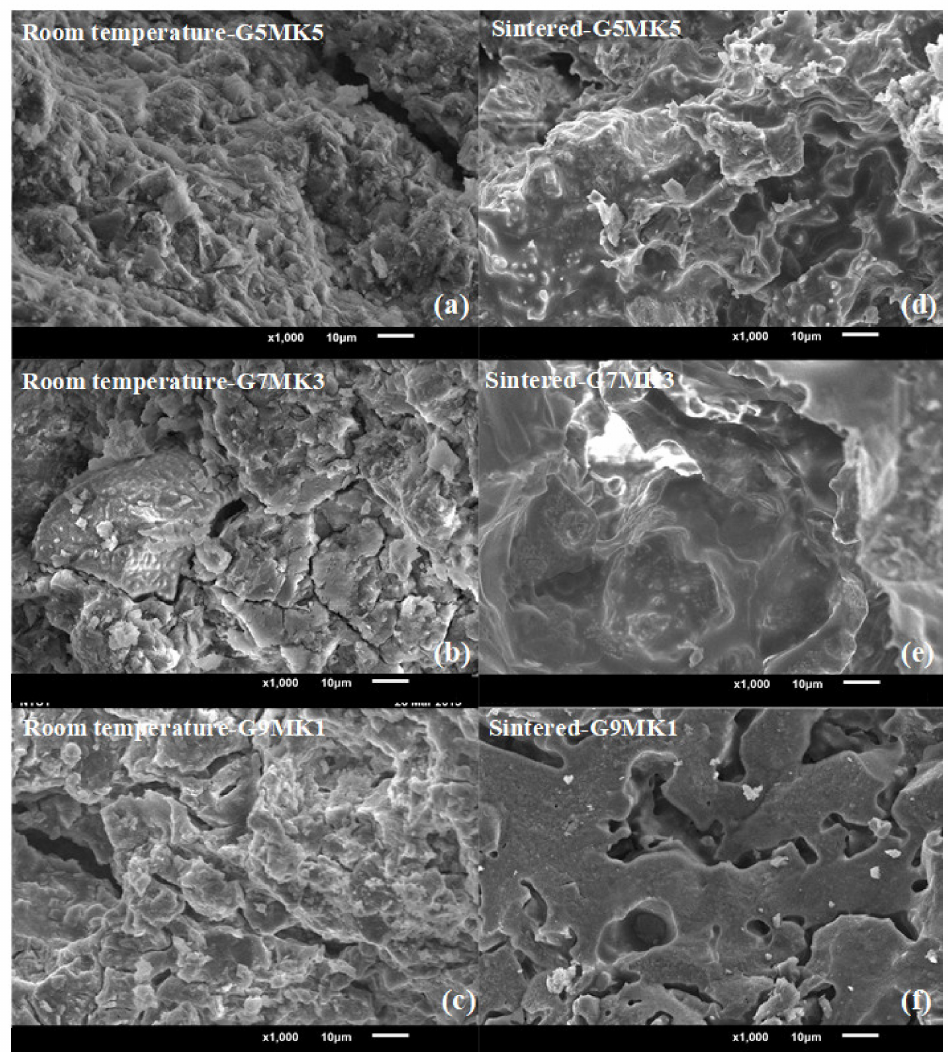
Figure 7. Scanning electron microscopy (SEM) micrograph of di ff erent carbonate / metakaolin ratios of geopolymer before ( a – c ) and after ( d – f ) sintering at 1200 ◦